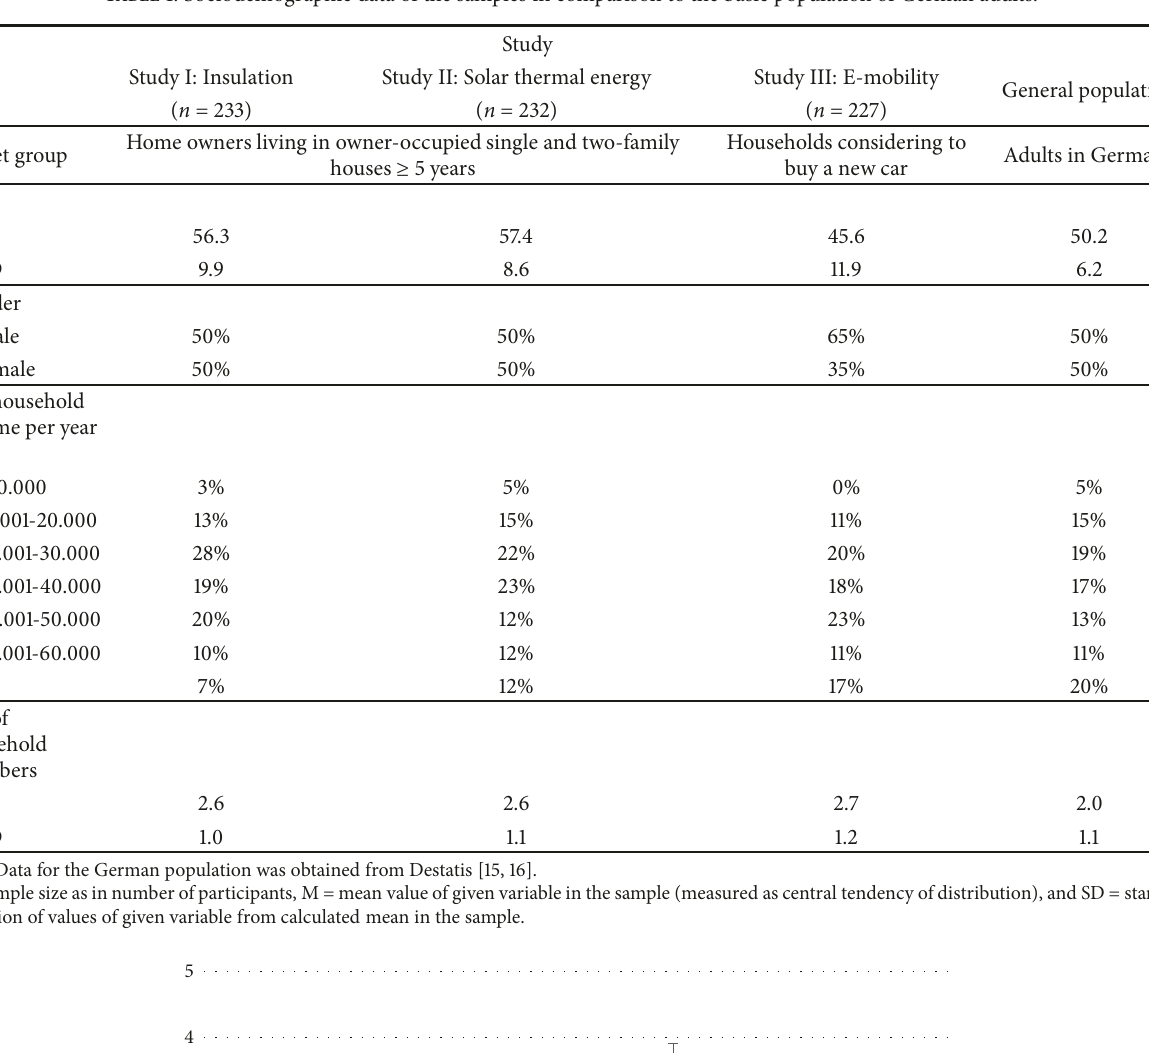
Table 1: Sociodemographic data of the samples in comparison to the basic population of German adults.